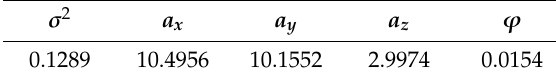
Figure 6. Selection of the range parameter. Table 2. Estimated parameter values of 𝜽 ∗ .